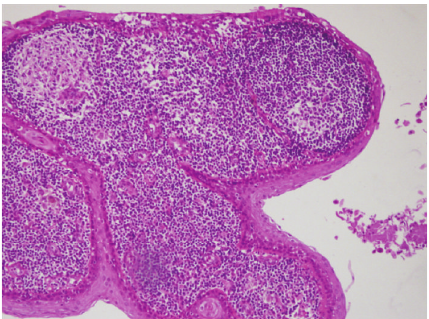
Figure 2: The cyst wall was lined with a stratified squamous epithelium surrounding the stroma consisting of lymphoid follicle structures with germinal centers. Fibroconnective tissue, adipose tissue, vascular structures, seromucous glands, and muscle tissue at the most external part were also observed in the stroma (H&E ×